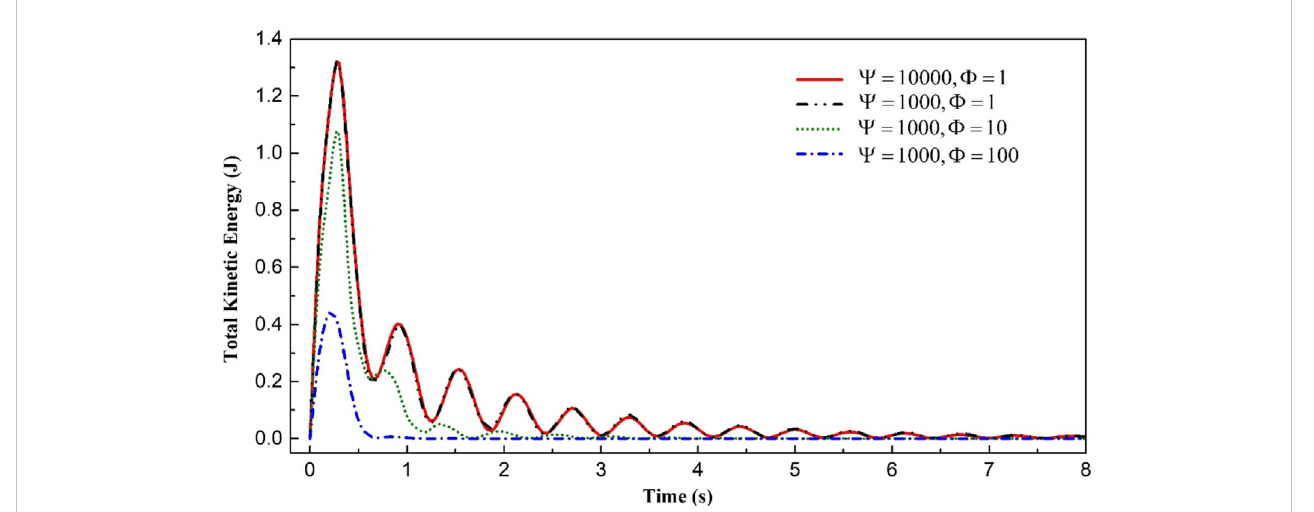
FIGURE 4 The variation of total kinetic energy of the droplet deformation with different density ratio and viscosity